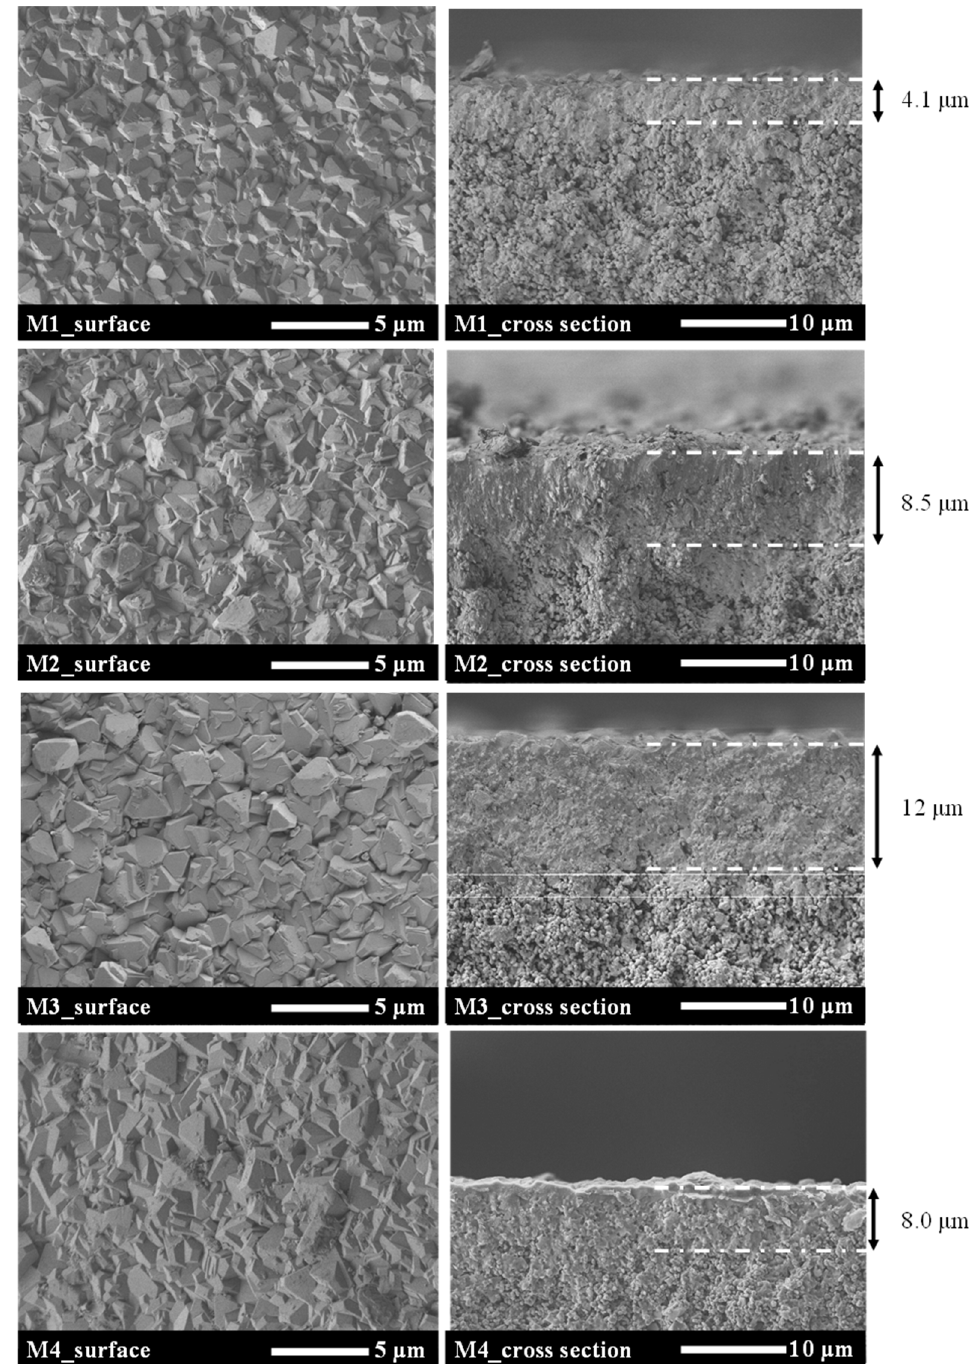
Figure 7. SEM images of the surfaces and cross-sections of Al-containing ZSM-58 zeolite membranes synthesized for various periods. The arrows denote the membrane thickness.